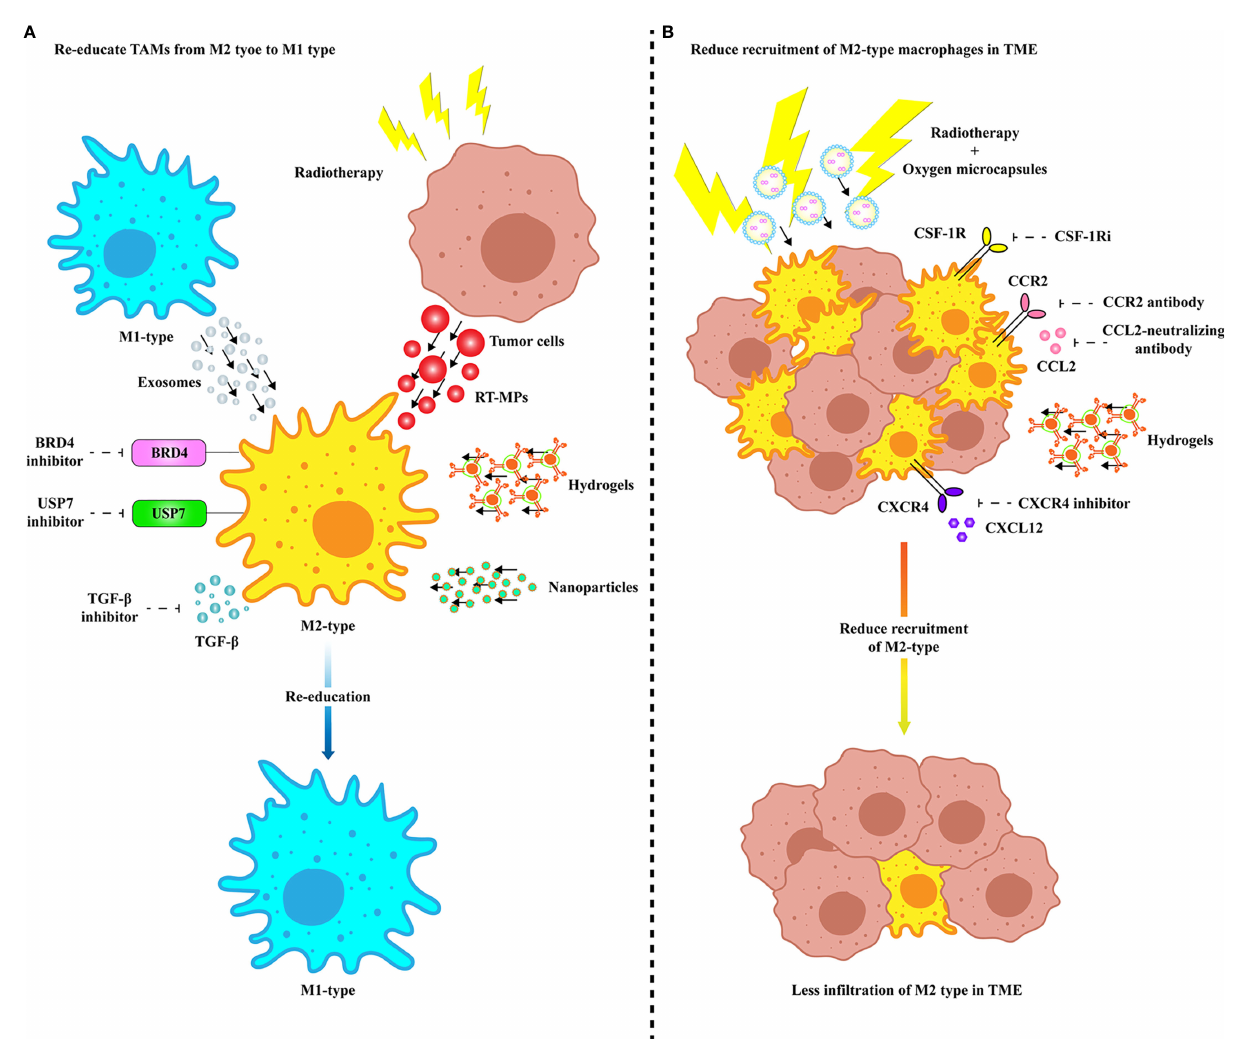
FIGURE 2 | Treatments targeting TAMs to improve anti-PD-1/PD-L1 ef fi cacy. (A) Multiple modes of re-education from M2 TAMs to M1 phenotype. Speci fi c inhibition of membrane proteins of M2 TAMs and TGF- b secretion can enable TAMs to obtain tumoricidal phenotype. M2 TAMs are repolarized to M1 type by internalizing vesicles from M1-type macrophages and radiated tumor cells. Precise targeting of TAMs in TME improves the ef fi cacy of anti-PD-1/PD-L1 therapy through drug delivery platforms such as nanovesicles and hydrogels. (B) Various ways to inhibit TAM recruitment and in fi ltration in TME. In fi ltration of TAMs in TME can be inhibited by speci fi c inhibition of receptors expressed on the surface of TAM cell membrane or by delivery of drugs via hydrogel. Radiotherapy combined with ameliorating the hypoxia microenvironment can effectively eliminate the in fi ltration of TAMs in TME. BRD4, Bromodomain-containing protein 4; CCL, C-C motif chemokine ligand; CCR, C-C motif chemokine receptor; COX-2, Cyclooxygenase 2; CSF-1R, Colony-stimulating factor 1 receptor; CSF-1Ri, CSF-1R inhibitor; CXCL, CXC-motif chemokine ligand; CXCR, C-X-C chemokine receptor; RT-MP, Microparticles released by radiated tumor cell; TGF- b , Transforming growth factor- b ; USP7, Ubiquitin-speci fi c protease